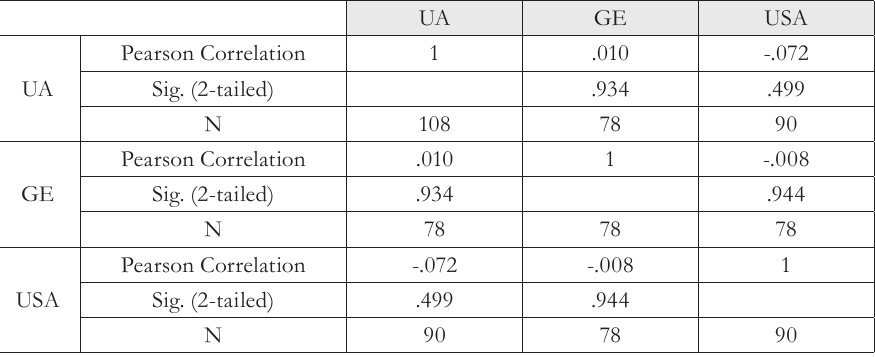
Tab. 11 - Correlation between countries according to AG (Pearson’s coefficient). Source: authors’